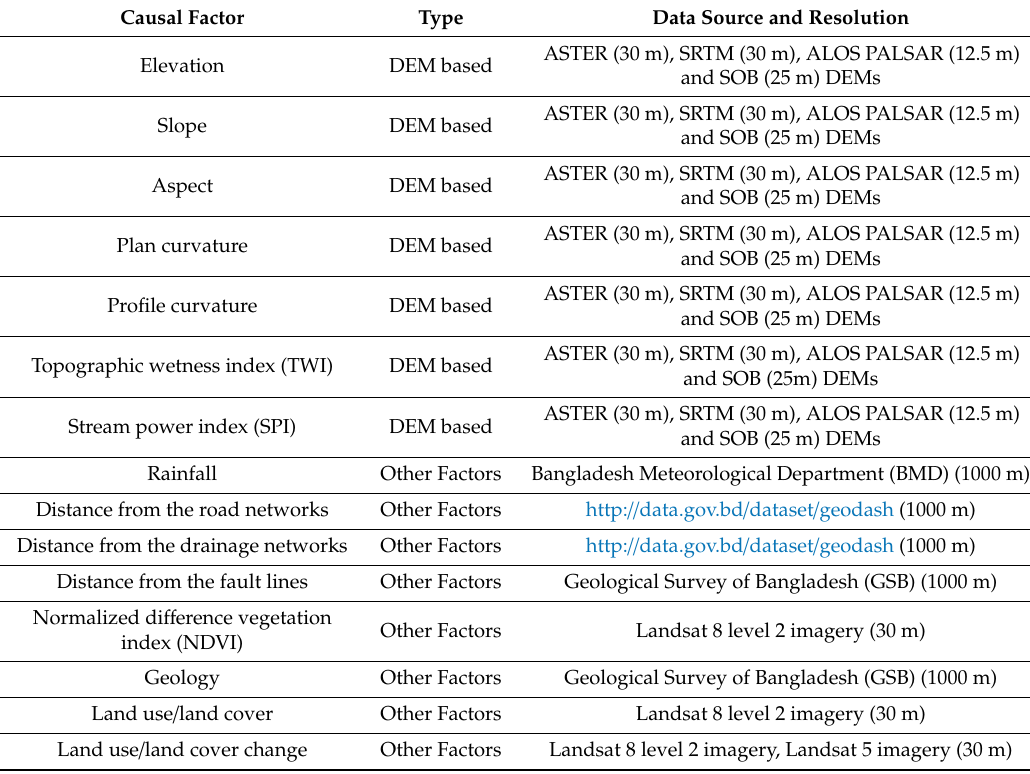
Table 1. Data source of the causal factors and